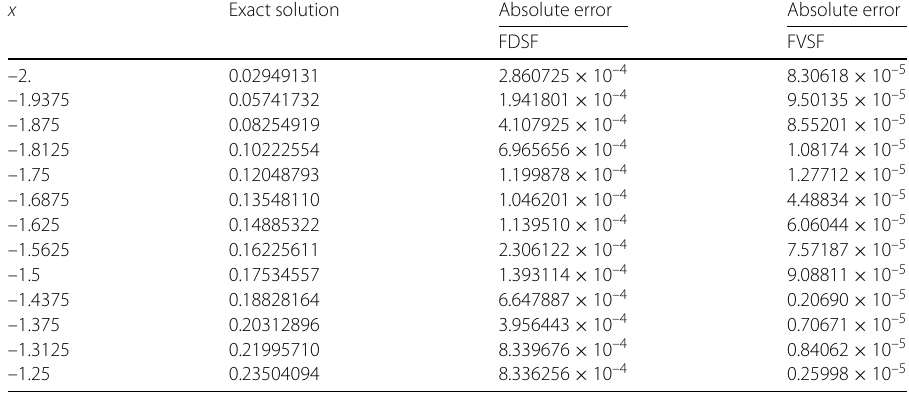
Table 4 Exact solution and absolute errors for Example 2 at time t = 1, β = 1, fixed h = 0.0625 and τ = 0.01